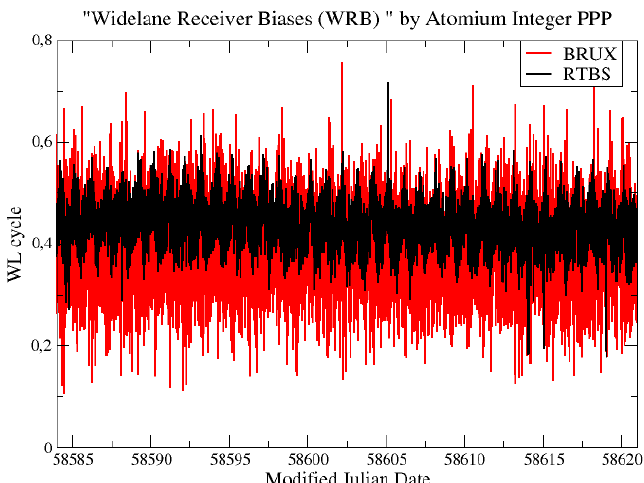
Figure 14. Wide-lane receiver bias (WRB) at station BRUX and RTBS estimated by integer PPP.